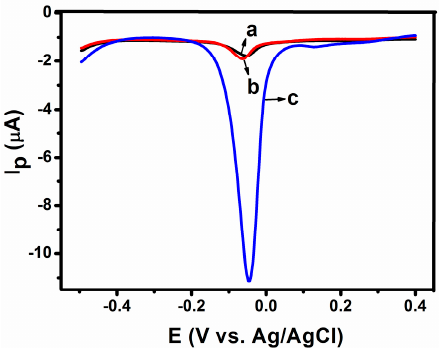
Figure 4. DPASV for 1.0 μ mol·L − 1 Cu (II) in 0.1 M NaAc-HAc (pH = 4.4) with different electrodes: ( a ) Bare GCE; ( b ) Nafion/GCE; and ( c ) RGO/CMC/Nafion/GCE. Detection conditions: amplitude of 0.05 V, pulse width of 0.06 s, and pulse period of 0.20 s.